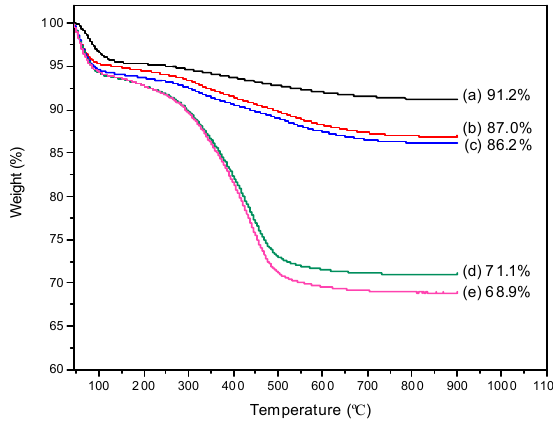
Figure 4. TGA analysis of ( a ) Si, ( b ) Si@NH 2 , ( c ) Si@BA, ( d ) HRP–MIP, and ( e ) NIP.